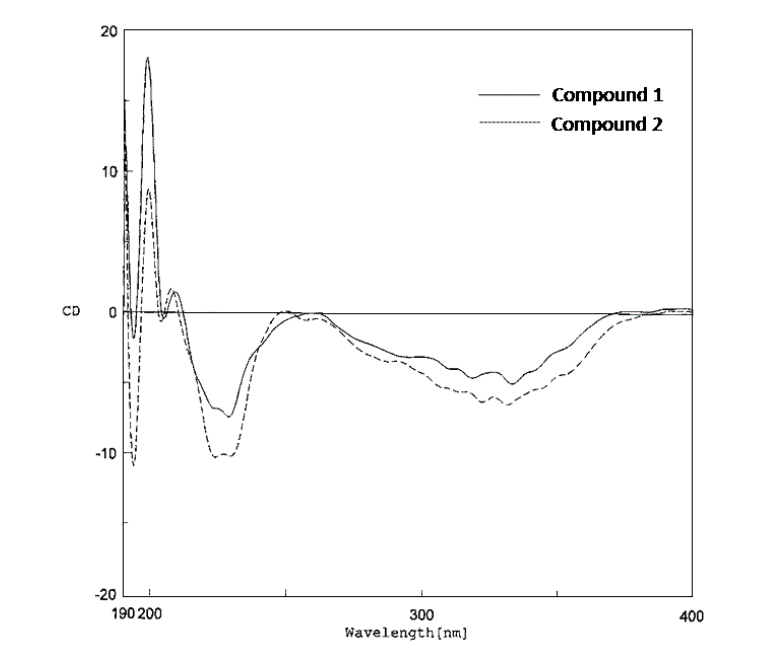
Figure 4. CD data of compounds 1 and 2